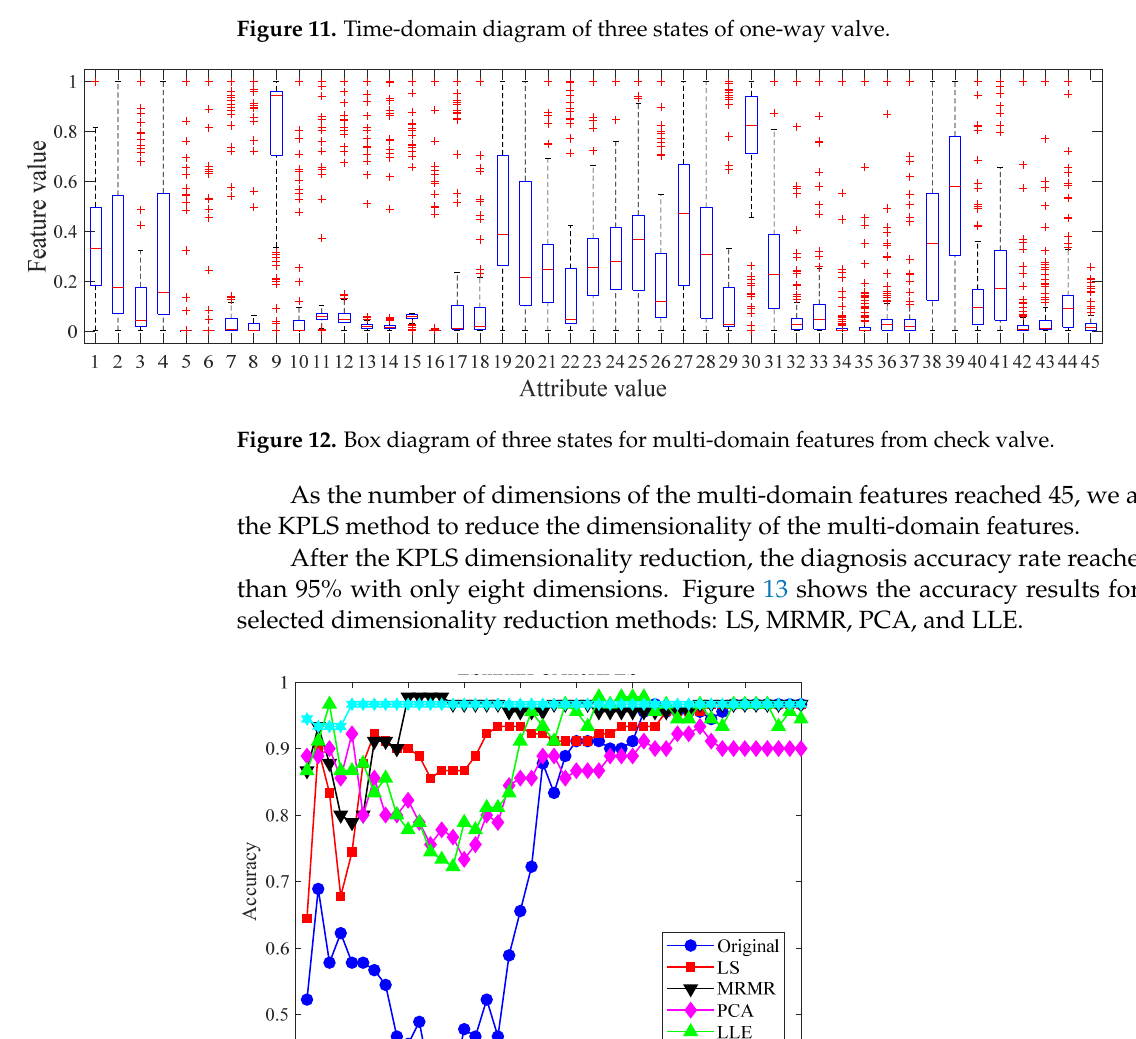
Figure 12. Box diagram of three states for multi − domain features from check valve.